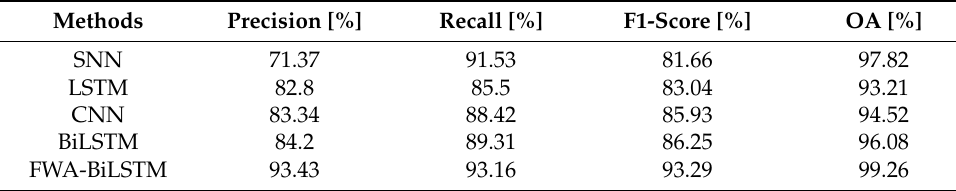
Figure 7. Classifier with attention layer on LEVIR-CD dataset.